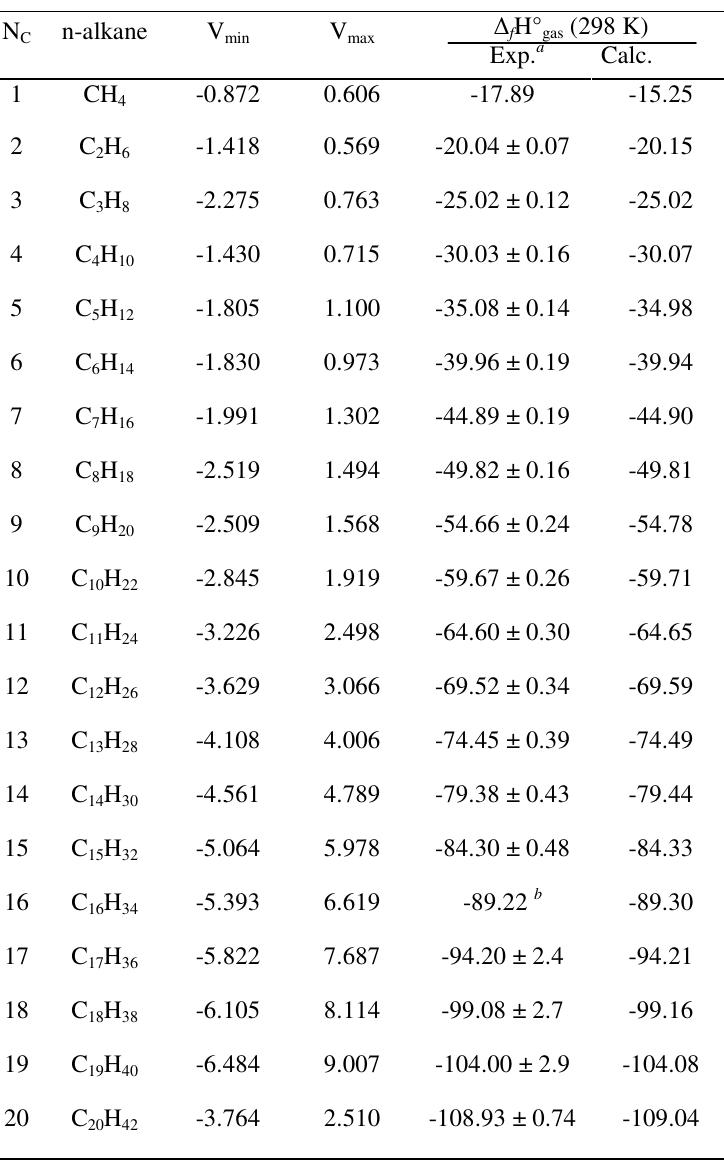
Table 1 Gas-phase heats of formation ∆ B3LYP/6-31++G**, (kcal mol -1